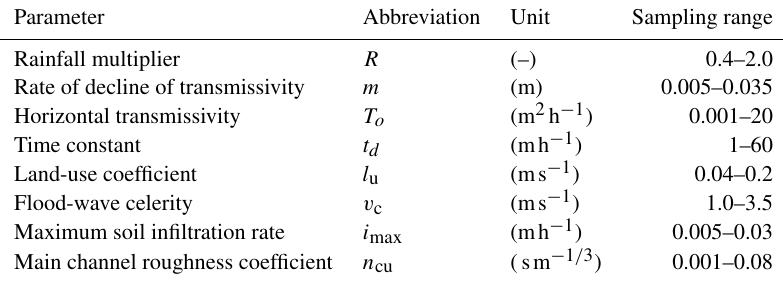
Table 2. Sampling parameter ranges to run the rainfall–runoff